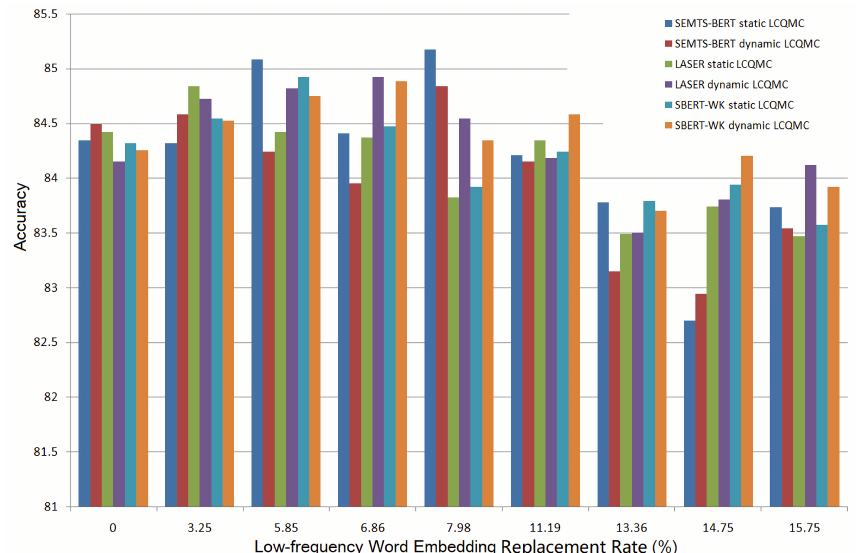
Figure 12. The influence of different low-frequency word embedding replacement rates on the performance of BiMPM evaluated on